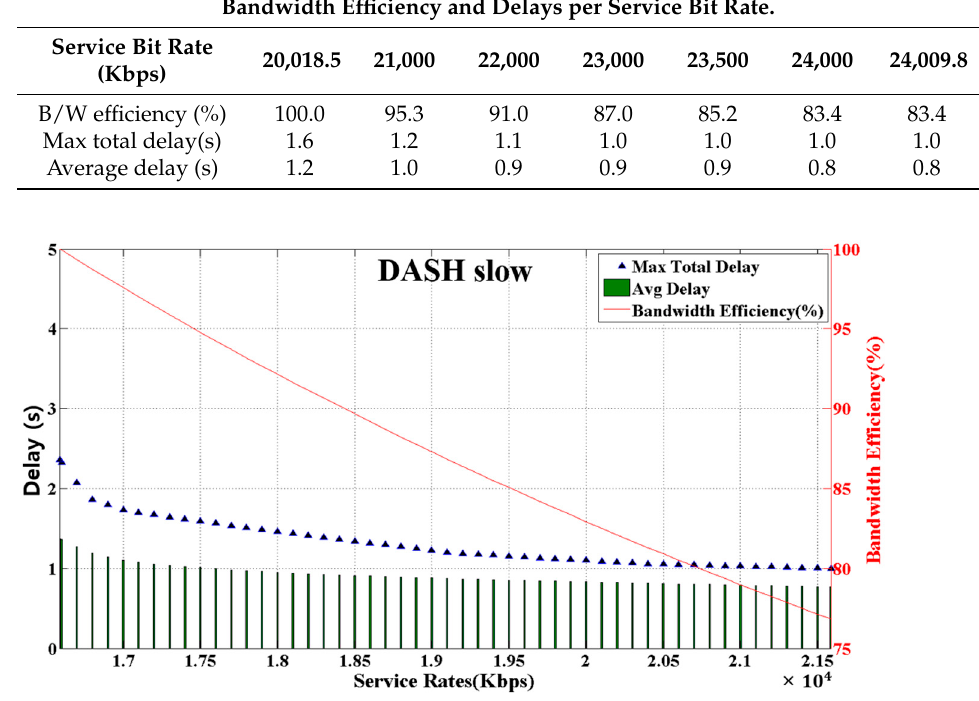
Figure 10. Simulation results of ‘DASH slow’. Table 10. Simulation results of ‘DASH slow’.